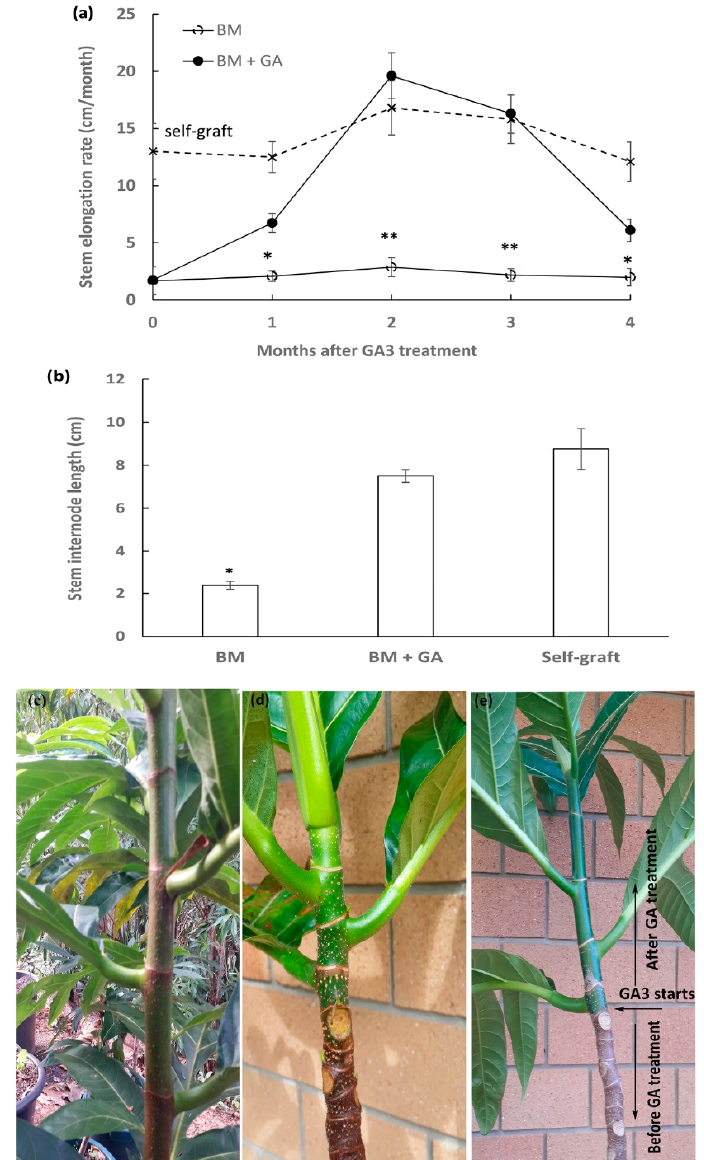
Figure 5. Rescue of scion stem elongation by exogenous GA 3 application in breadfruit plants on marang rootstocks: Comparison of stem elongation rate ( a ) and internode length ( b ) in GA 3 -treated and non-treated plants. Representatives of grafted plants displaying different scion stem internodes: ( c ) Untreated breadfruit scions on breadfruit rootstock (self-graft), ( d ) untreated breadfruit scions on marang rootstock, and ( e ) GA 3 -treated breadfruit scions on marang rootstock. The stem internode length was the averaged measurement of the second internodes at the third month after GA 3 treatment. BM, breadfruit plants growing on marang rootstocks. All values represent mean ± SE from three biological replicates, with ** significant di ff erence ( p < 0.05) from the rest of the samples (non-graft and self-graft) and * significant di ff erence from the non-graft only.